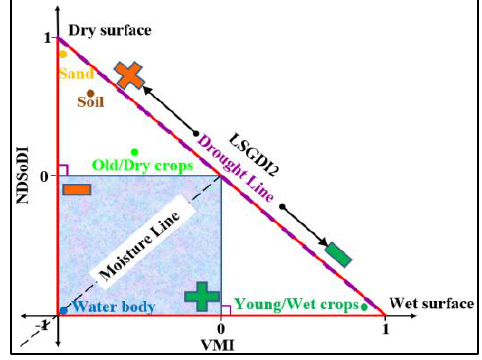
Figure 9. LSGDI2 on the VMI-NDSoDI orthogonal plan The moisture square includes the water body in both VMI and NDSoDI lower values, and its diagonal, the moisture line, separates two triangles representing the both indices areas of influence. The value needed equals to the triangles right angles projection, named the drought line, and corresponding to the